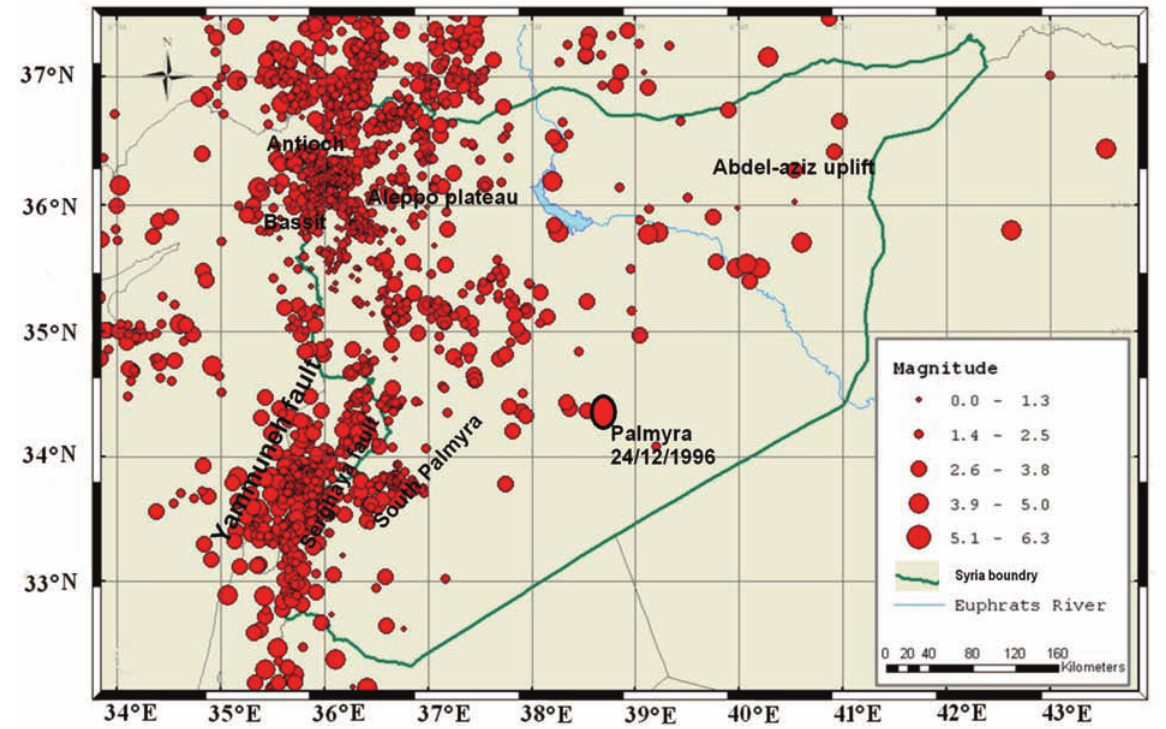
Figure 3. Earthquake activity in Syria and its nearby regions, as documented by the Syrian National Seismological Network from 1995 to 2004 (modified from Alchalbi